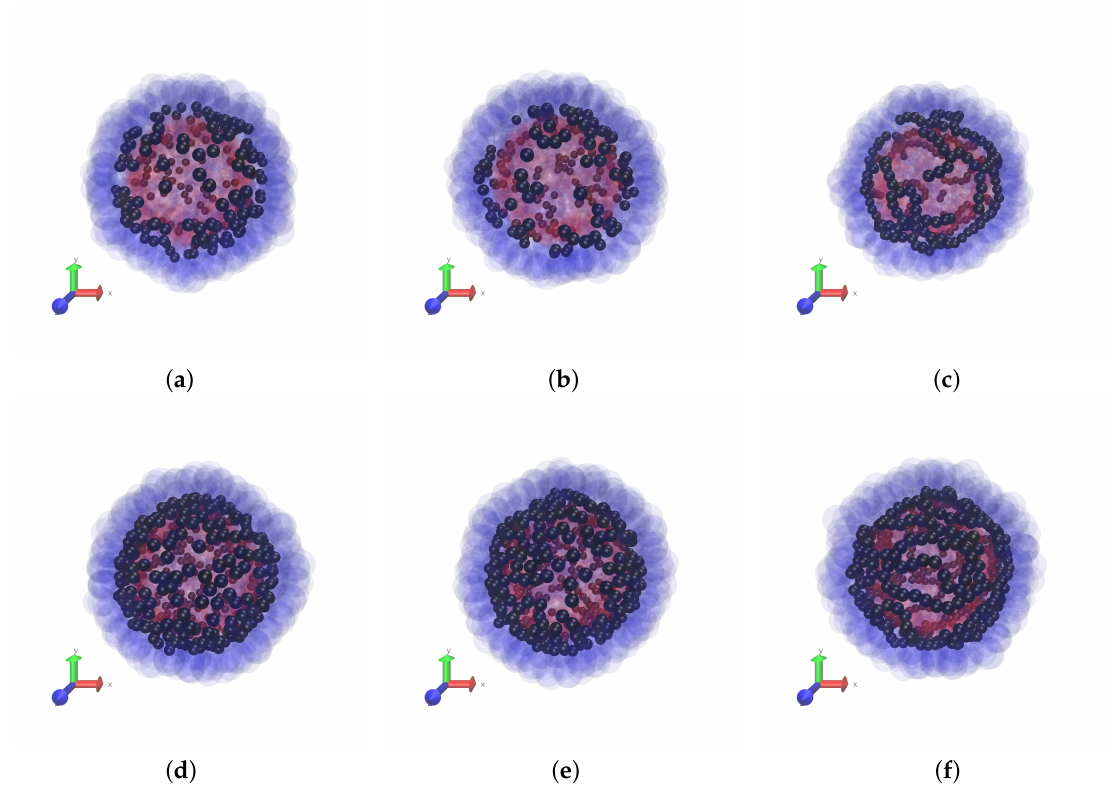
Figure 2. Zero field case. Snapshots of the particle distribution in the MPS membrane